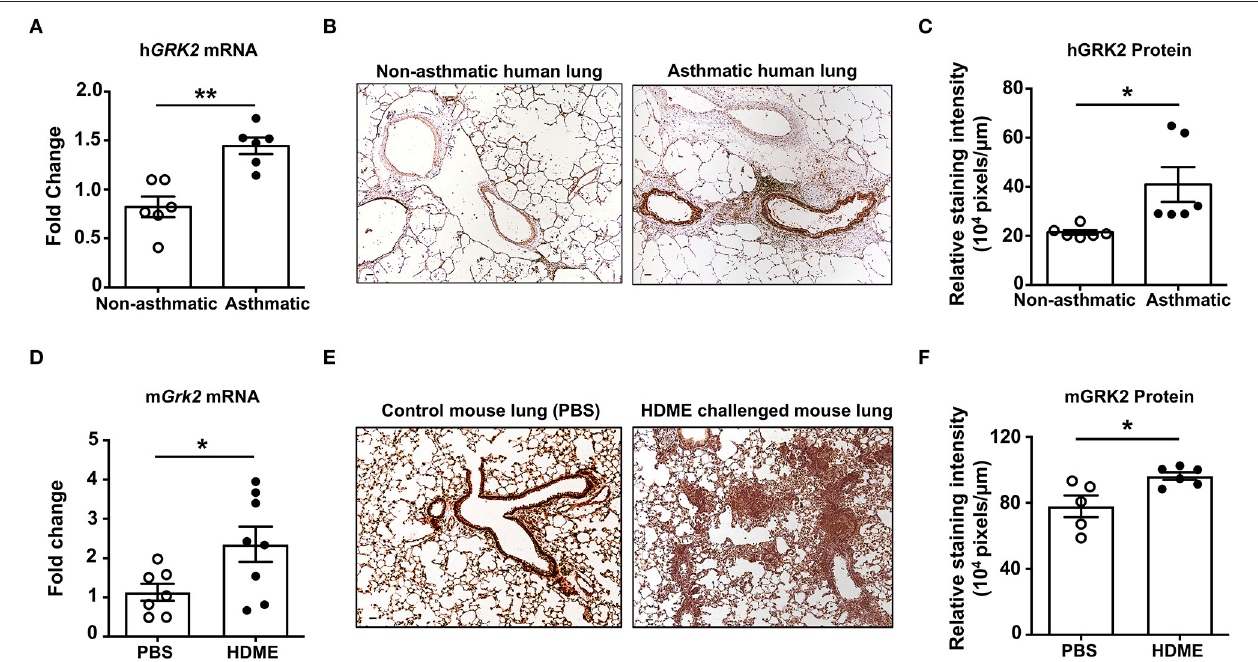
FIGURE 1 | Increased levels of GRK2 in the lungs of human asthmatics and HDME-challenged mice. (A) Whole lung tissue from healthy donors and asthma patients were analyzed for mRNA expression of human (h)GRK2. Data is shown as mean fold change ± SEM with a total of 6 samples per cohort. (B,C) Immunohistochemistry (IHC) was performed to determine GRK2 levels in the lungs of healthy donors and asthma patients. (B) Representative images from 6 donors for each group and (C) relative staining intensity of GRK2 expression are shown. (D–F) Male and female B6 mice were challenged intranasally (i.n.) with PBS or HDME (50 µ g) on alternate days for a total of seven injections. Twenty-four hours after the last treatment mice were euthanized and the lung tissue was harvested and (D) analyzed for mRNA expression of mouse (m)GRK2. Data is shown as mean fold change ± SEM from 7 to 8 samples per cohort. IHC of mouse lung tissues were performed and (E) representative images of GRK2 staining in the lungs of 5–6 mice from each cohort is shown. (F) Relative staining intensity of GRK2 expression in the mouse lung samples is shown. Scale bar = 100 µ m. Statistical significance was determined by using Student’s unpaired t test. * p ≤ 0.05, ** p ≤